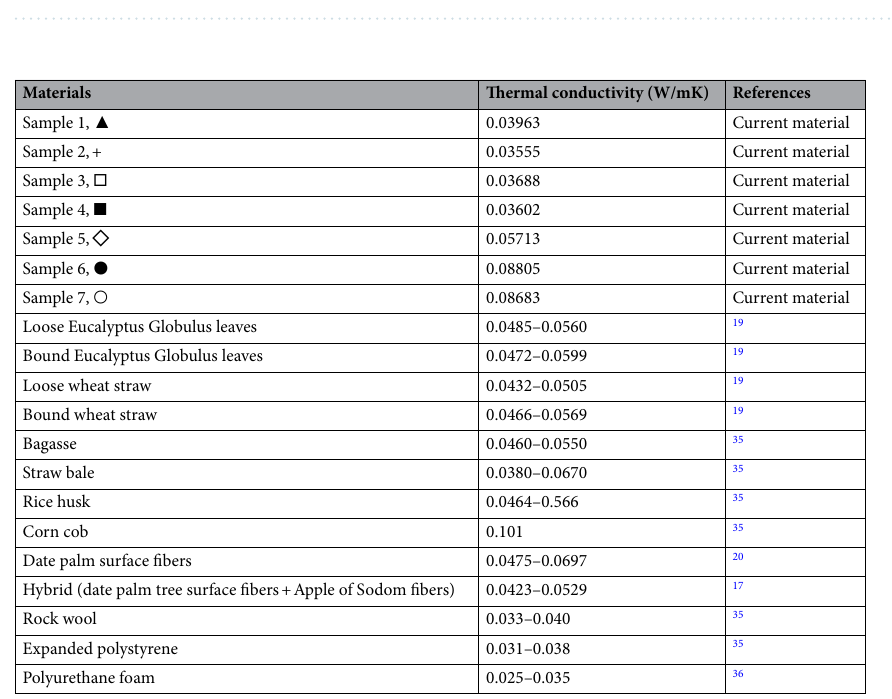
Figure 18. Thermal conductivity coefficient profiles at different temperatures for melted masks samples and for elastic ear loops.